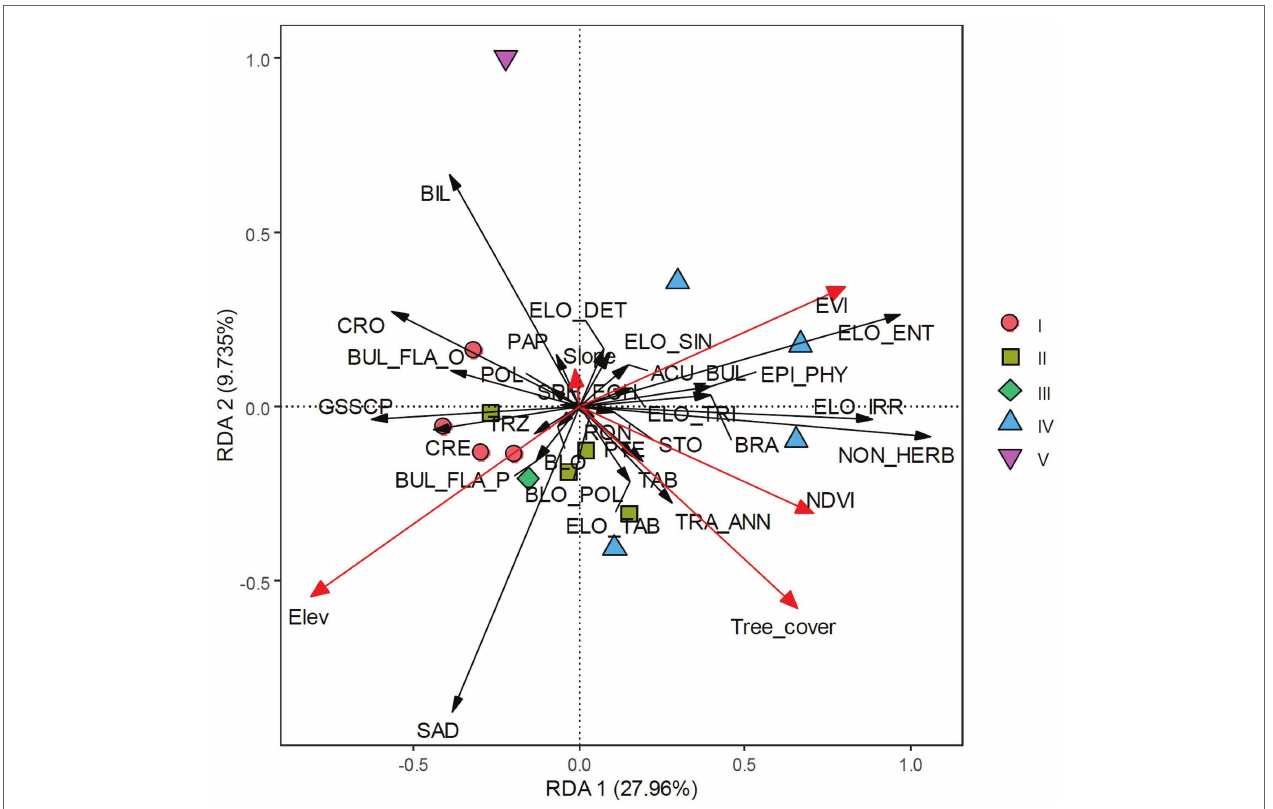
FIGURE 5 | Redundancy analysis (RDA) plot of environmental parameters and phytolith taxa. Scatter points show the first two axis scores. Group I represents evergreen shrub-meadow plots, Group II represents coniferous broadleaf mixed forest plots, Group III represents bamboo forest plot, Group IV represents broadleaf forest plots, and Group V represents anthropogenic deforested shrubland plots, respectively.